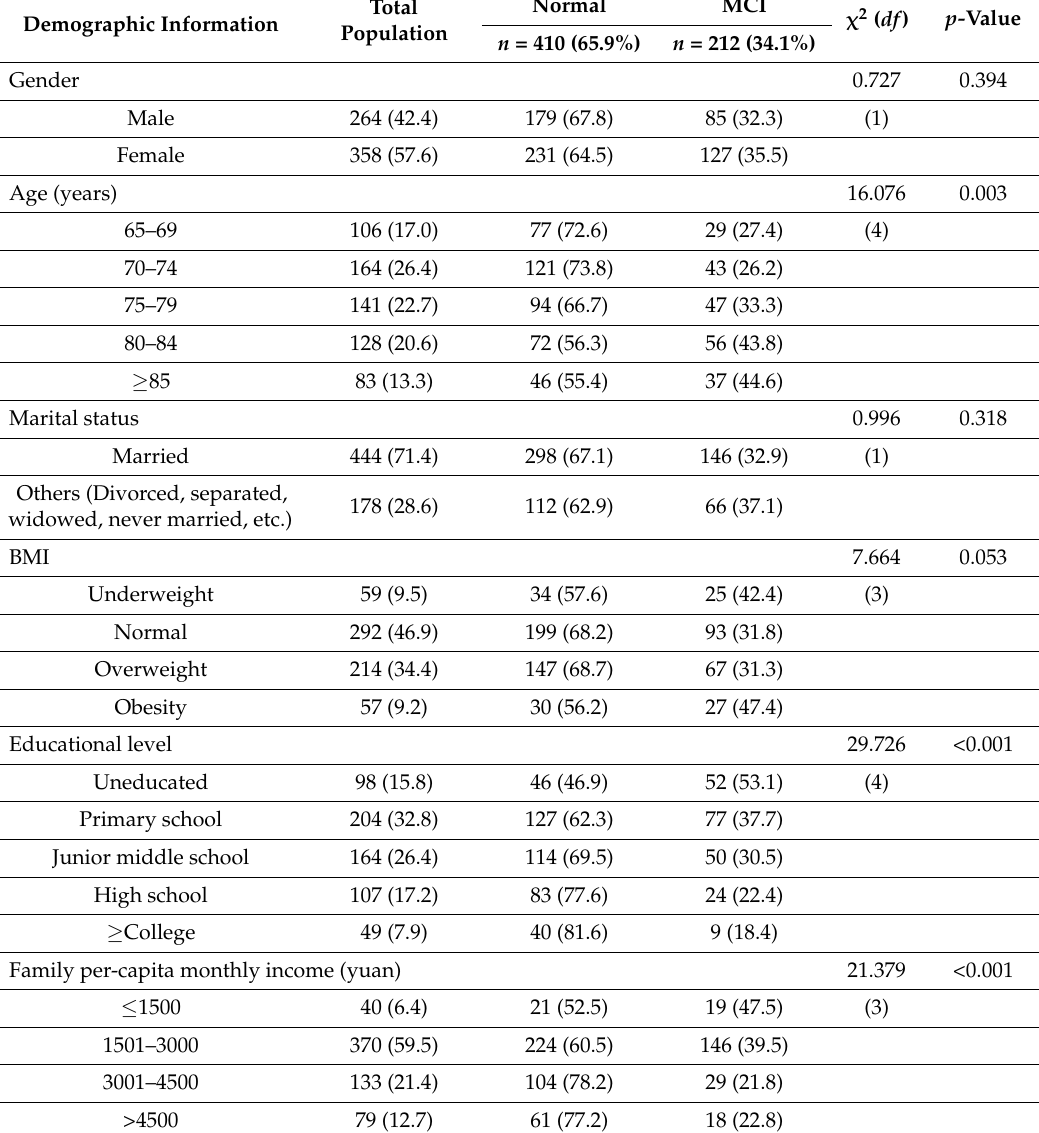
Table 1. Demographic information of participants stratified by cognitive status ( n = 622). Total Demographic Information Population